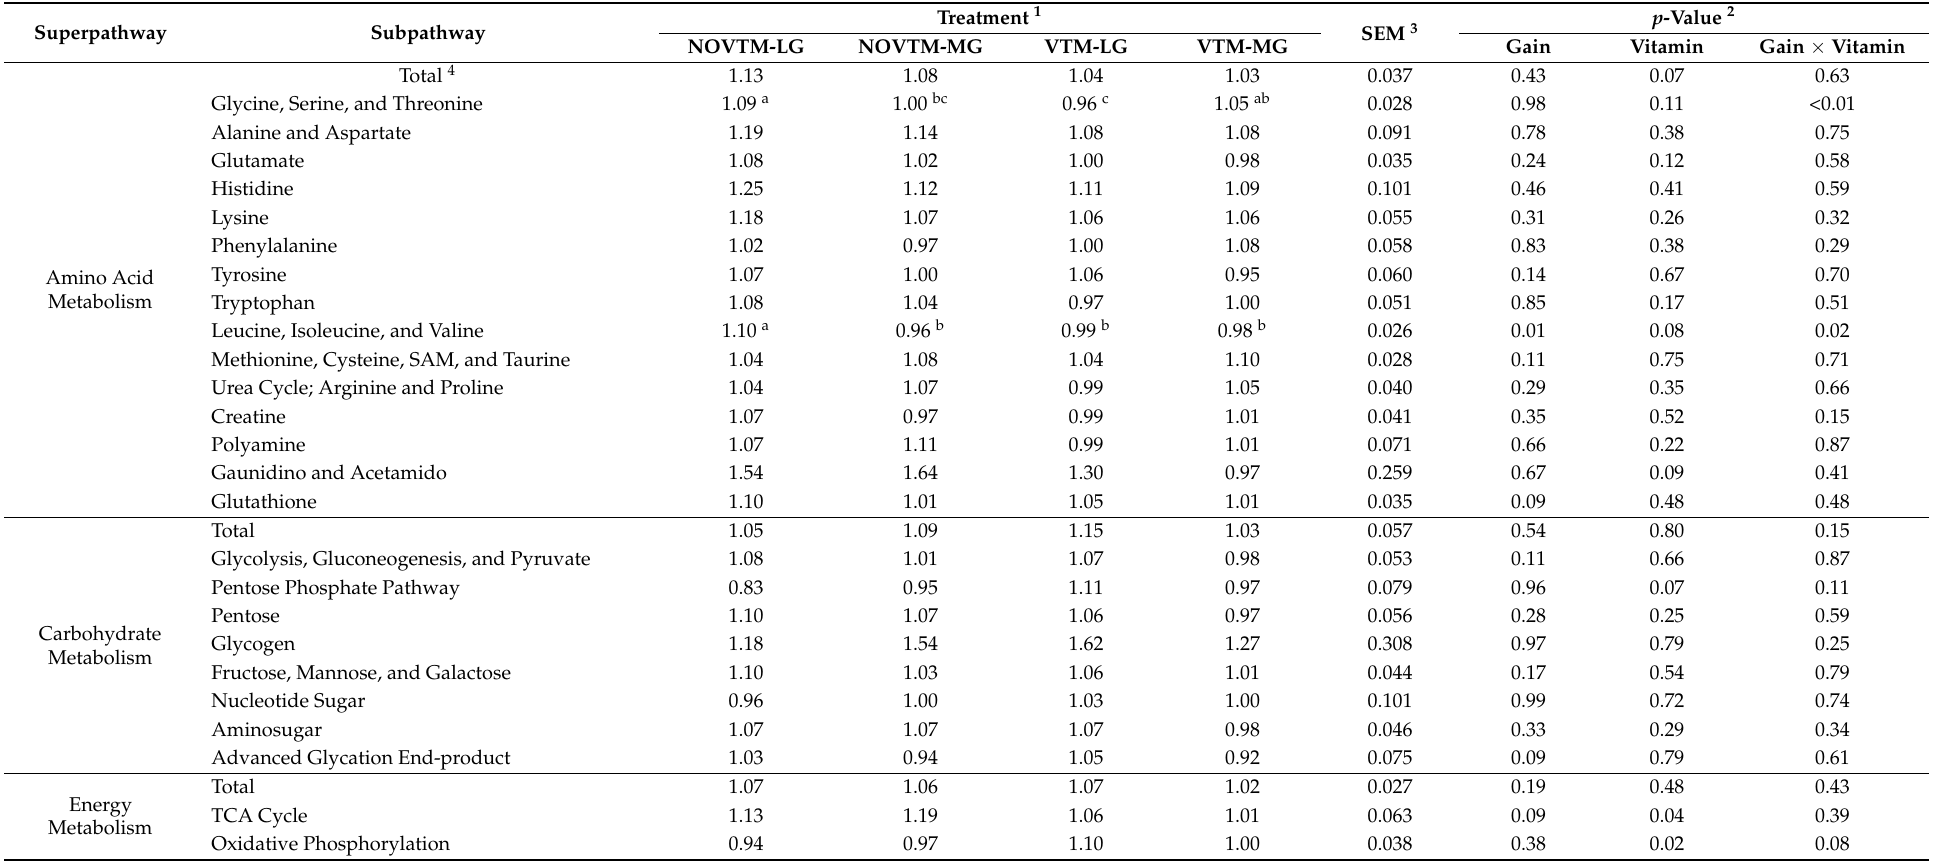
Table 7. Average abundances of metabolites within a